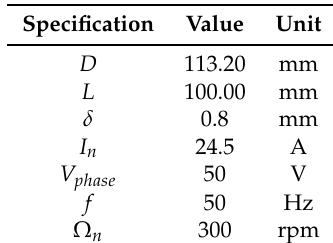
Table 4. Design specifications.